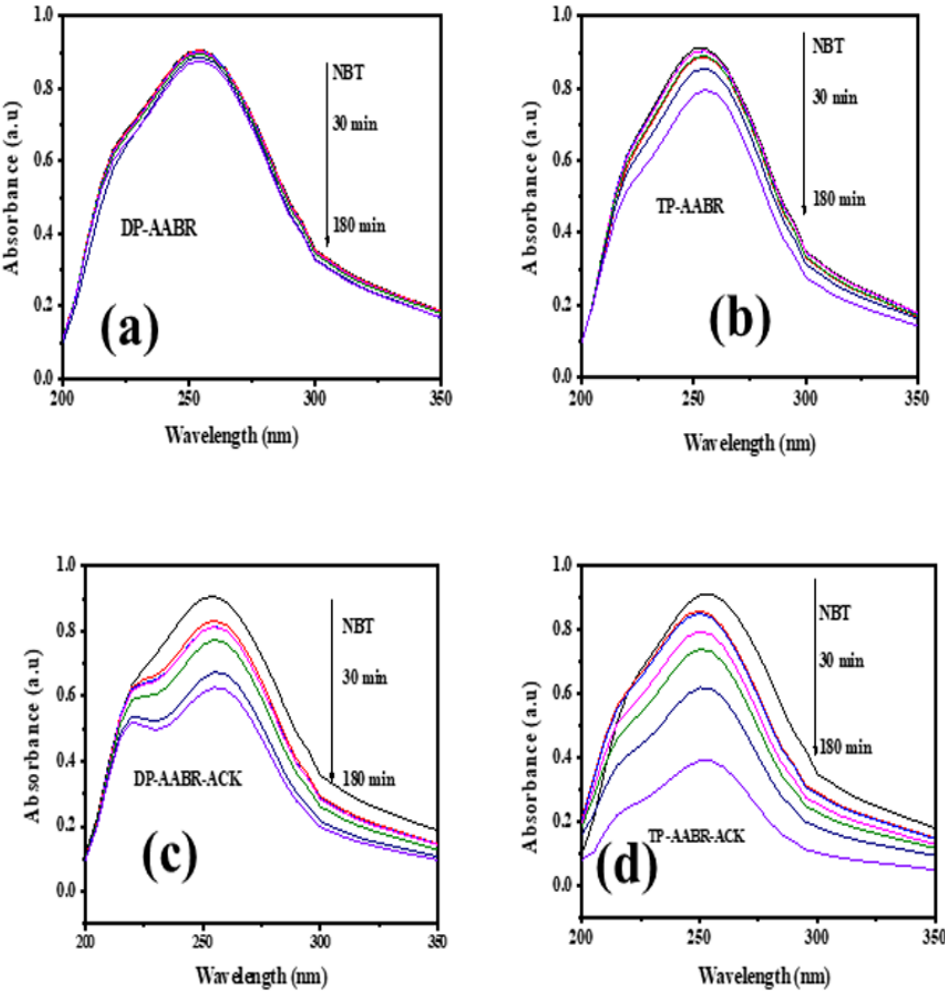
Figure 11. UV-Vis absorption spectra of NBT degraded by ( a ) DP-AABR, ( b ) TP-AABR, ( c ) DP-AABR-ACK, and ( d ) TP-AABR-ACK.